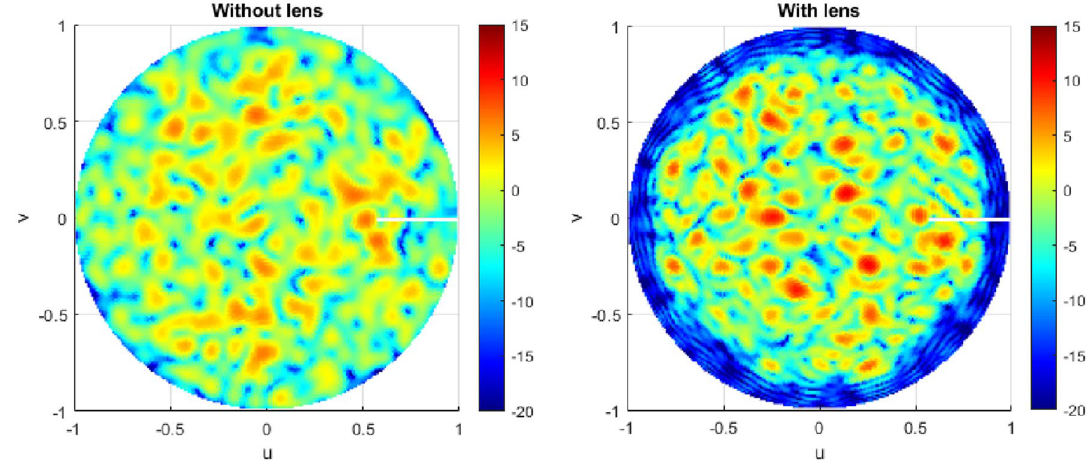
Figure 4. Impact of the presence of constant- ε r lens in front of the chaotic cavity on the FoV described using simulated peak realized gain at a test frequency of 28.1 GHz in UV plane